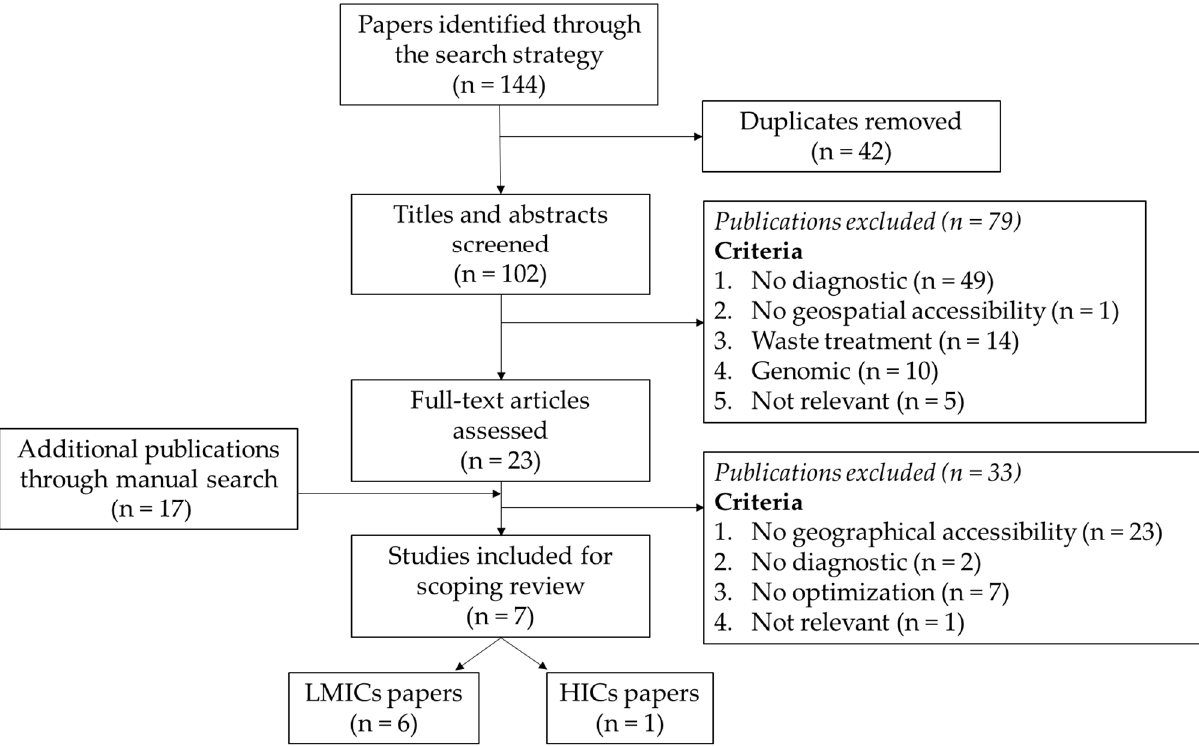
Figure 1. Overview of the article selection process and selected article at each step.